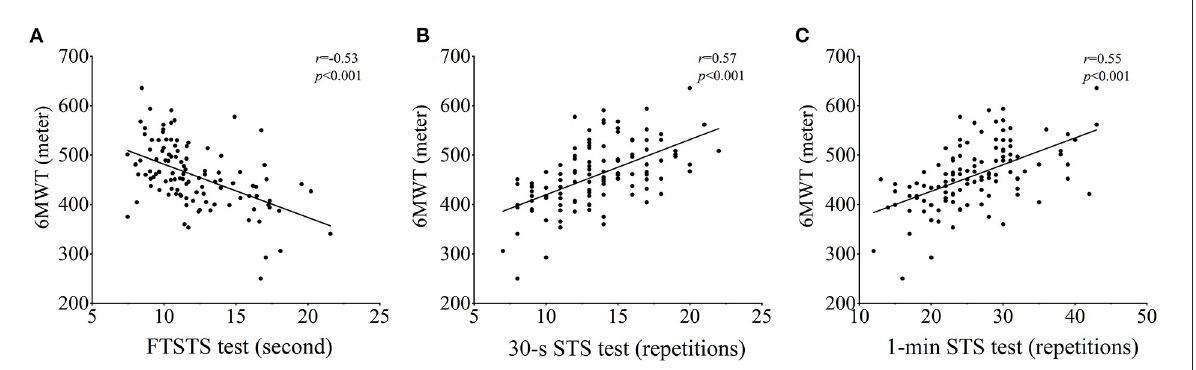
FIGURE1 Correlations between 6MWT and the 3 STS tests. FTSTS test: five times sit-to-stand test, 30-s STS test: 30-sec sit-to-stand test, 1-min STS test: 1-min sit-to-stand test, 6MWT: six-min walk test.